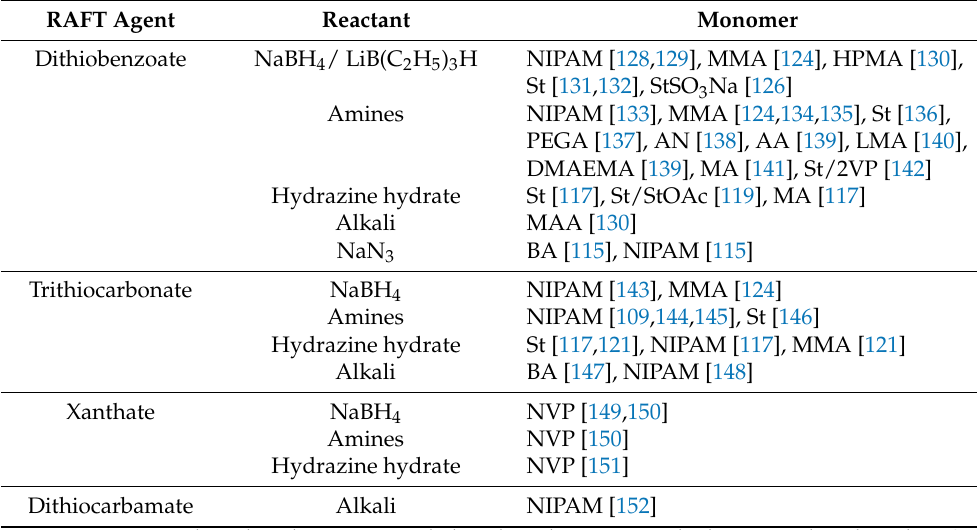
Table 2. Nucleophiles and reducing agents for the conversion of the thiocarbonylthio moiety in the ZC(=S)S group for various RAFT agents and